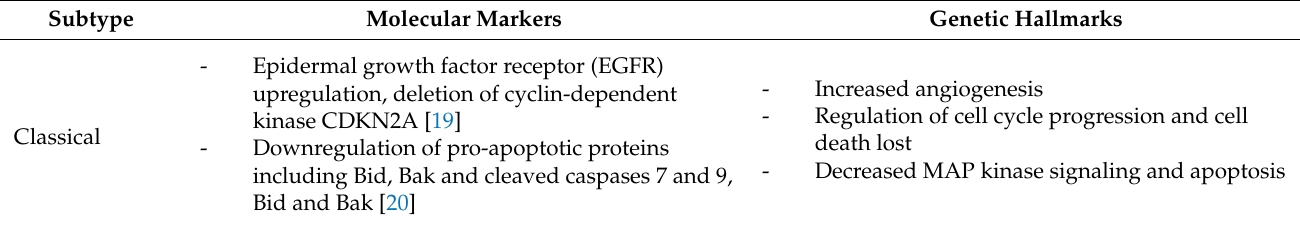
Table 1. Molecular markers and genetic hallmarks of the glioblastoma subtypes, defined by Verhaak and colleagues [19] and expanded by Brennan and colleagues